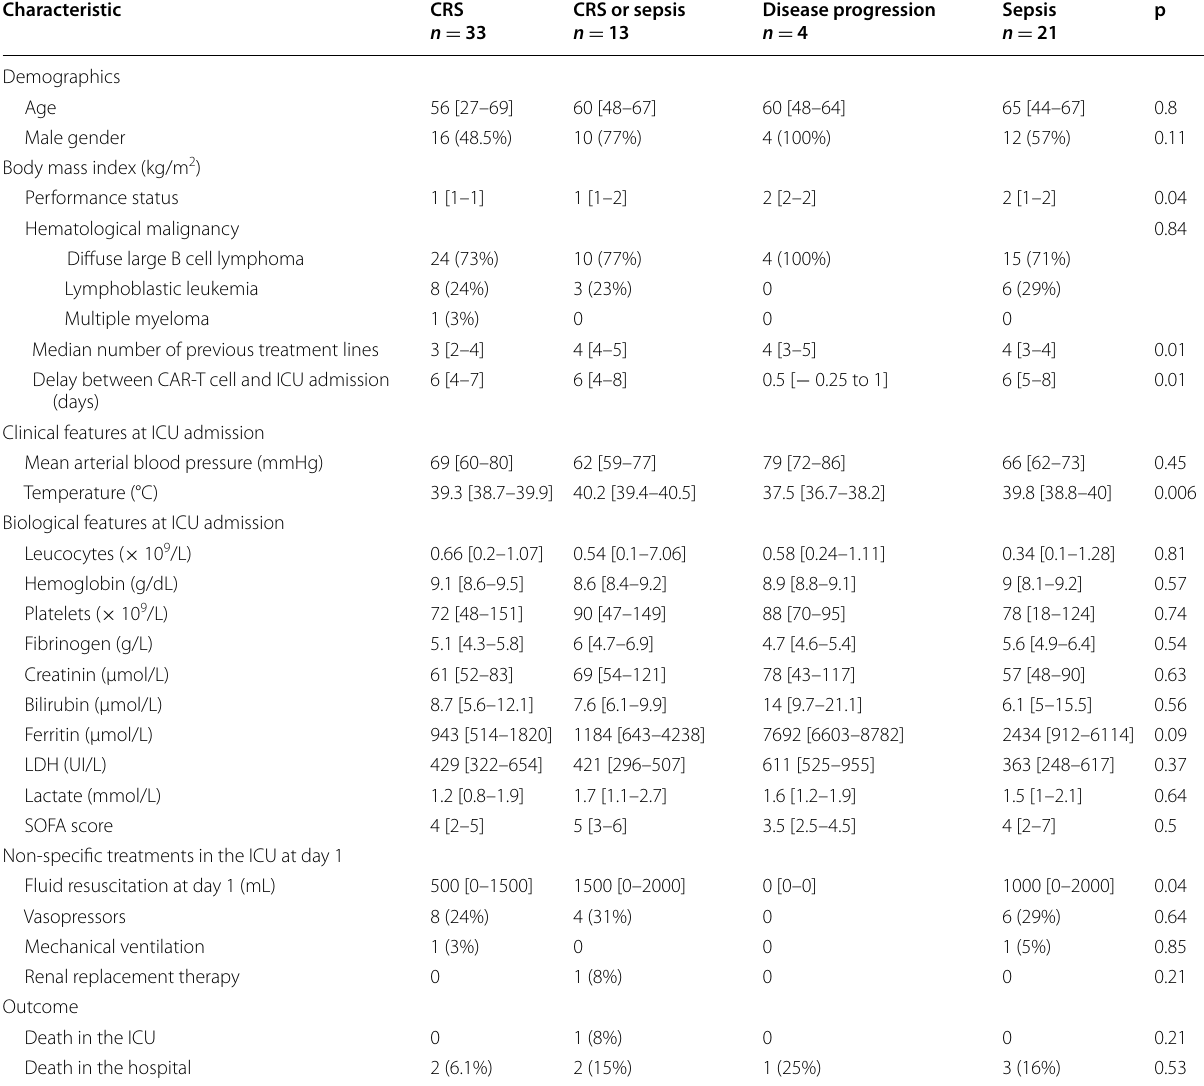
Table 3 Characteristics of CAR-T cells patients according to the reason for ICU